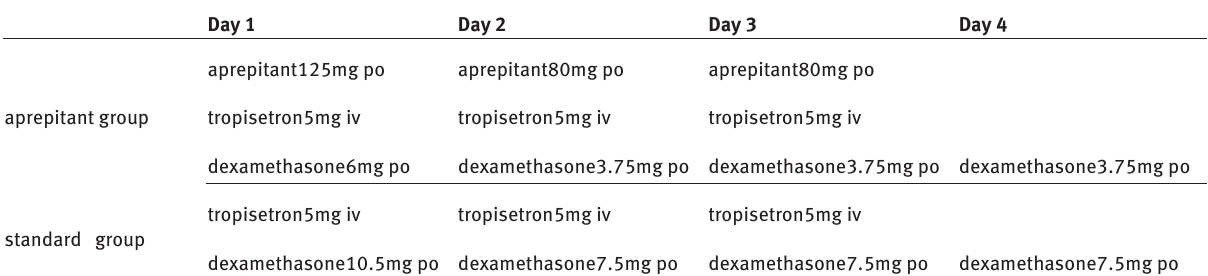
Table 2: The Medication